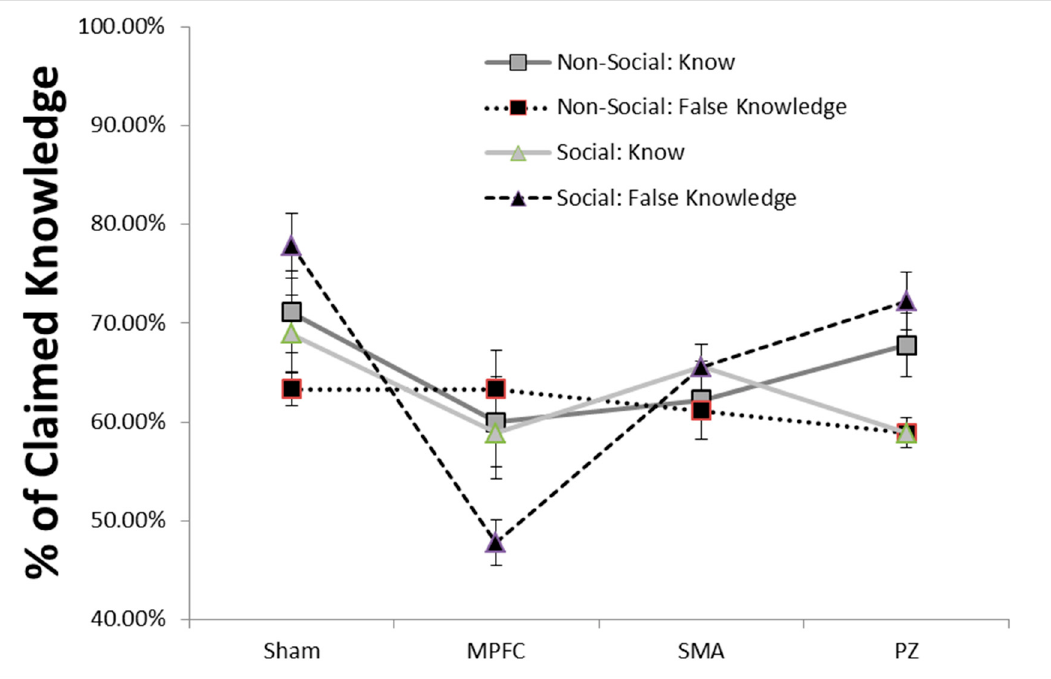
Figure 1. Transcranial magnetic stimulation (TMS) delivered to the medial prefrontal cortex (MPFC) had a significant impact in terms of percent of claimed knowledge. The vertical axis indicates the percent of yes responses for either real words (knowledge) or fake words (false knowledge). It was found that TMS delivered to the MPFC significantly reduced the participants’ overclaiming ( p < 0.04).